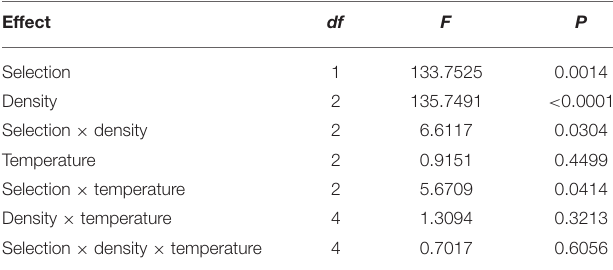
TABLE 5 | Results of ANOVA for mean